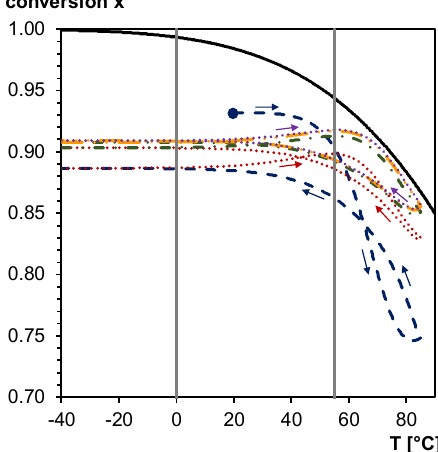
Figure 17. Equilibrium conversion ( full black line ) and simulated Diels–Alder conversion for the 3M-F375PMA reversible network in five consecutive day cycles. Dashed blue line : first day cycle (starting from the simulated Diels–Alder conversion after the two-step synthesis of 0.93 at 20 ◦ C); Dotted red line : second day cycle; Dash-dotted green line : third day cycle; Dash-dot-dotted orange line : fourth day cycle; Dotted purple line : fifth day cycle. Equilibrium hysteresis loop is reached after five day cycles. Vertical grey lines : T g region of the 3M-F375PMA reversible network.